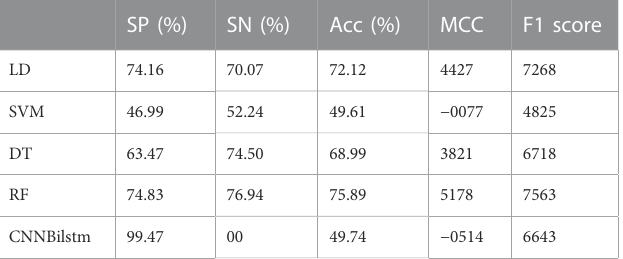
TABLE 3 The performances of CSKAAP